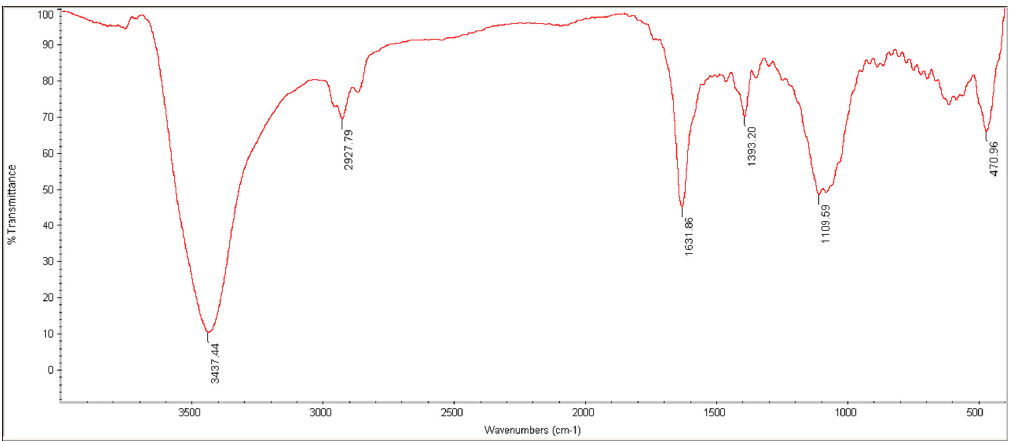
Figure 4. FTIR spectra of SeN.